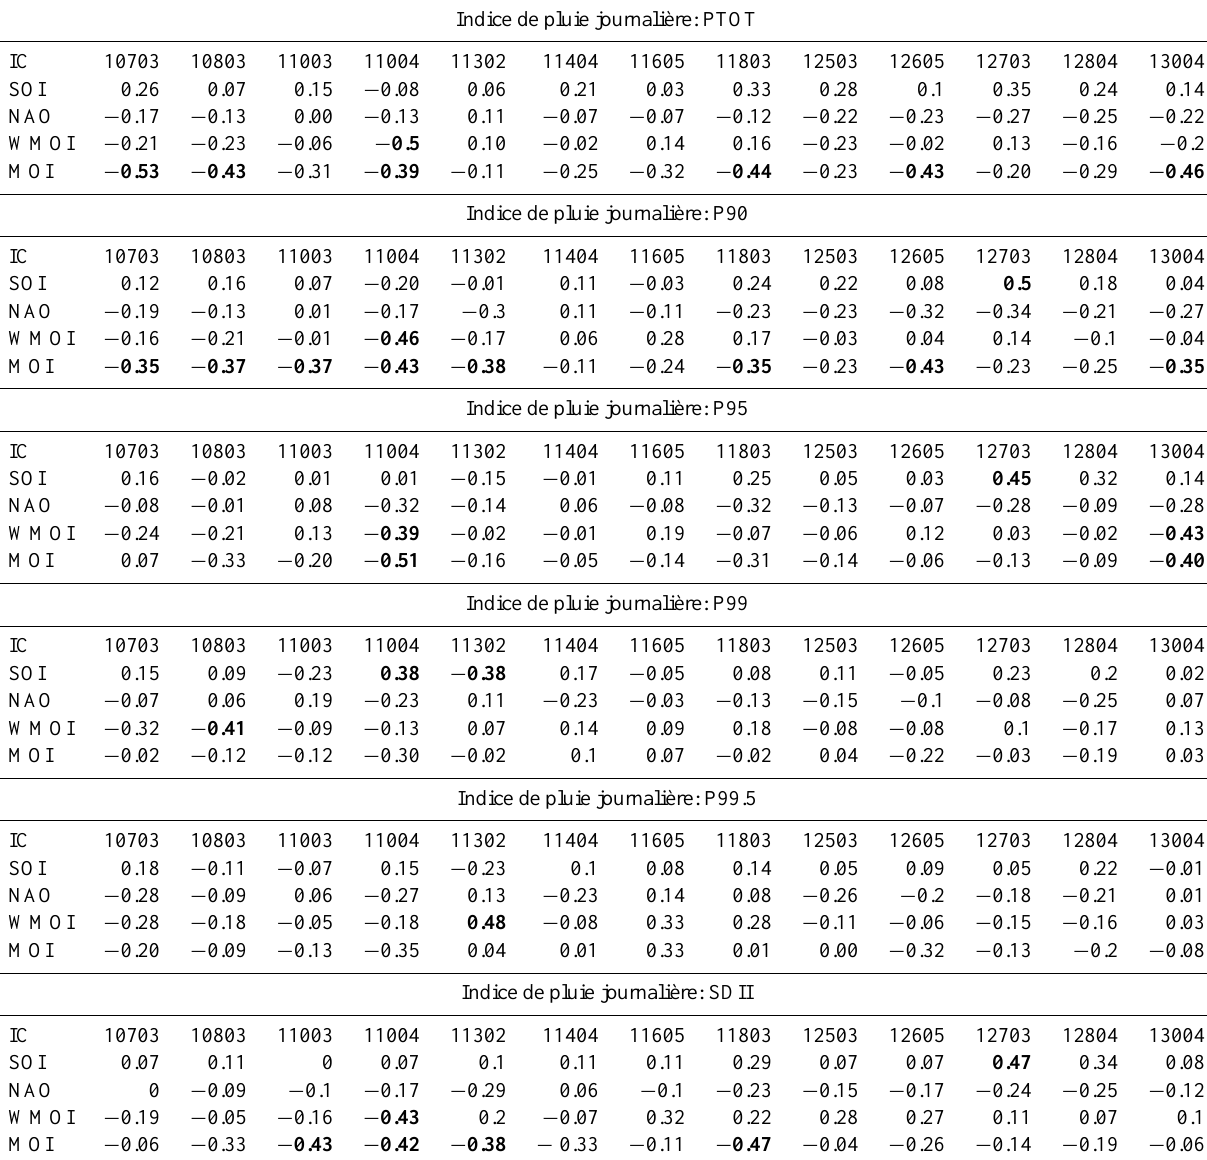
Tableau 3. Coefficient de corrélation de Pearson entre les indices de pluies journalières et les indices climatiques (valeurs significatives en gras au niveau